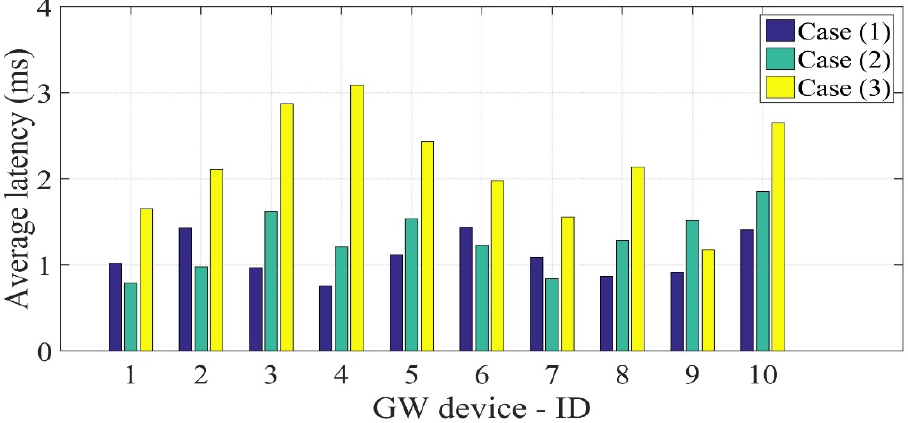
Figure 10. Average latency of handling GW devices’ tasks for the three considered cases of the first scenario.